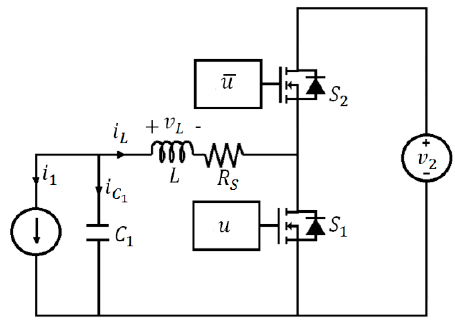
Figure 5. Circuit diagram of the BHBC operating in buck mode.